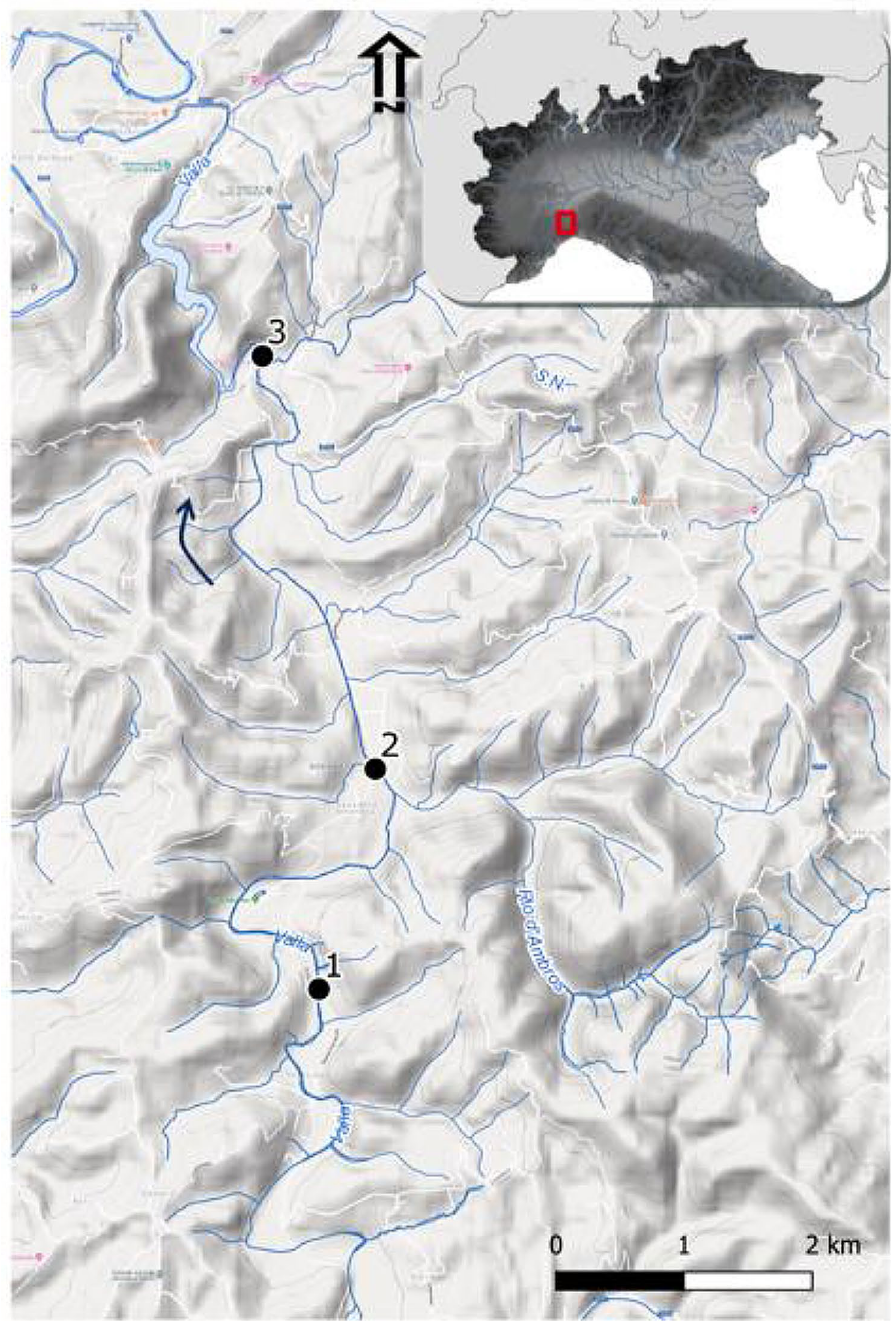
Figure 8. Map of Valla Stream and sampling sites. The arrow indicates the direction of flow. The base map is from Google Terrain Hybrid (https:// cloud. google. com/ maps- platf orm/ terms) and the hydrography layer available by Regione Piemonte WMS service (http:// www. geopo rtale. piemo nte. it). The map was created using QGIS 3.10 LTR—A Coruña (https:// www. qgis.